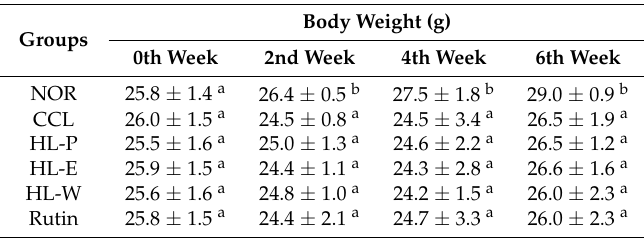
Table 1. The effects of red quinoa and its extracts on the body weight gain of the CCl 4 -induced liver injury mice.